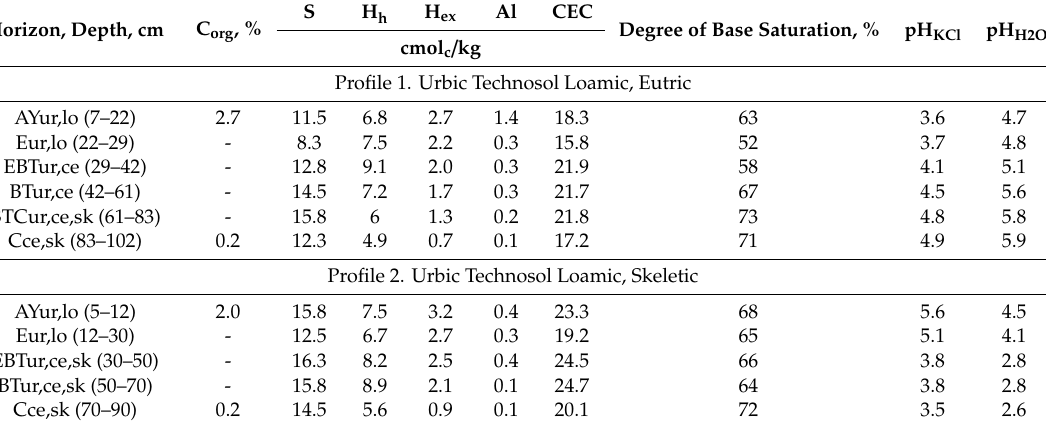
Table 2. Physicochemical properties of soil of Gubakha.